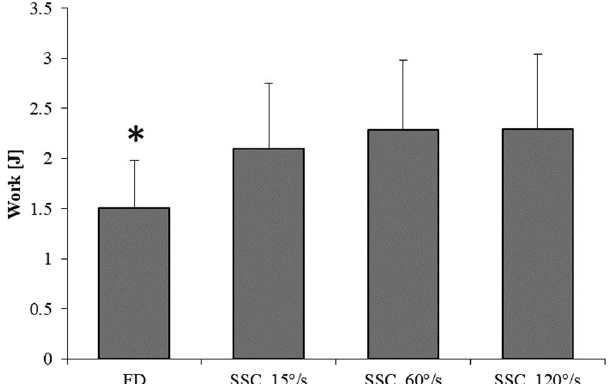
Figure 5. Mean ( ± SE) values of work performed during shortening for the pure FD test and the SSC tests performed at different stretching speeds (SSC_15°/s, SSC_60°/s, and SSC_120°/s). The work performed during shortening for all SSC was significantly greater compared to that measured for the pure FD test. ( * Compared to all SSC; p < 0.001).